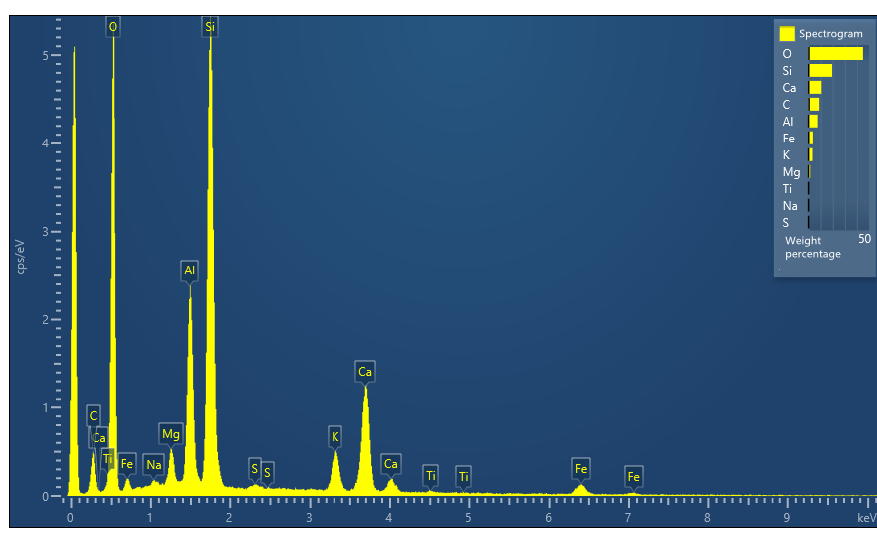
Figure 14. XRD patterns of the ordinary- and composite-cemented soil, cured for 7 d.